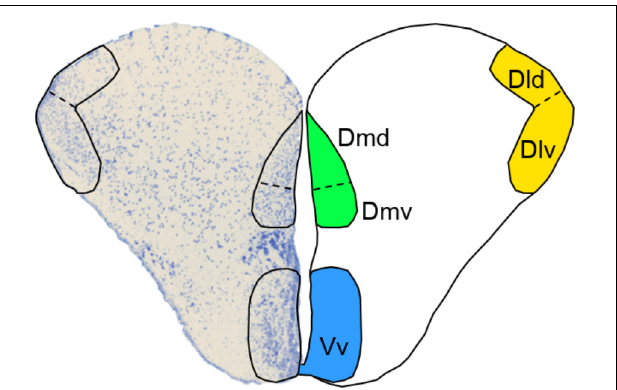
FIGURE 1 | Selected subregions of the telencephalon. A transverse view of the Atlantic salmon telencephalon with a Toluidine Blue-stained left lobe and a schematic representation of the right lobe depicting the location of the dorsal (Dld) and ventral (Dlv) dorsolateral pallium, the dorsal (Dmd), and ventral (Dmv) dorsomedial pallium and the ventral part of the ventral telencephalon